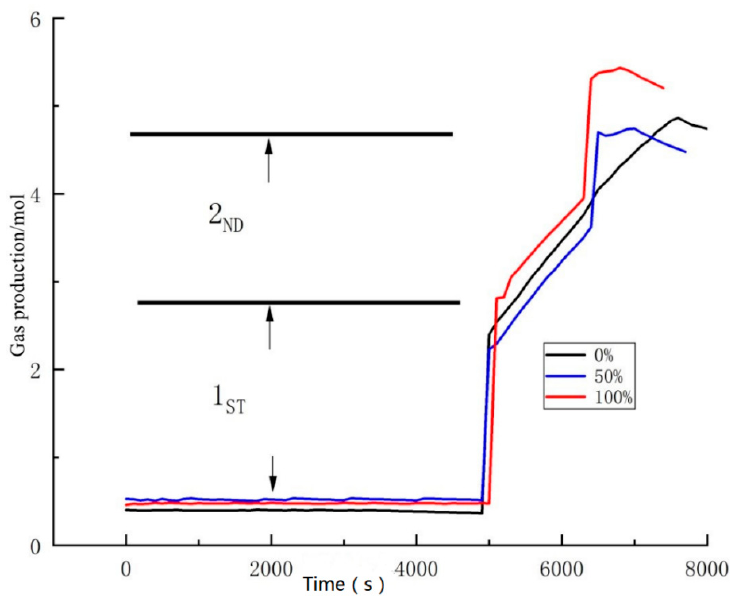
Figure 6. Amount of produced gas versus time plot under 0%, 50%, and 100% SOC. When the quantity of gas produced by the battery is calculated using the equation of state for ideal gases law it is obvious that the eruption occurs in two phases.